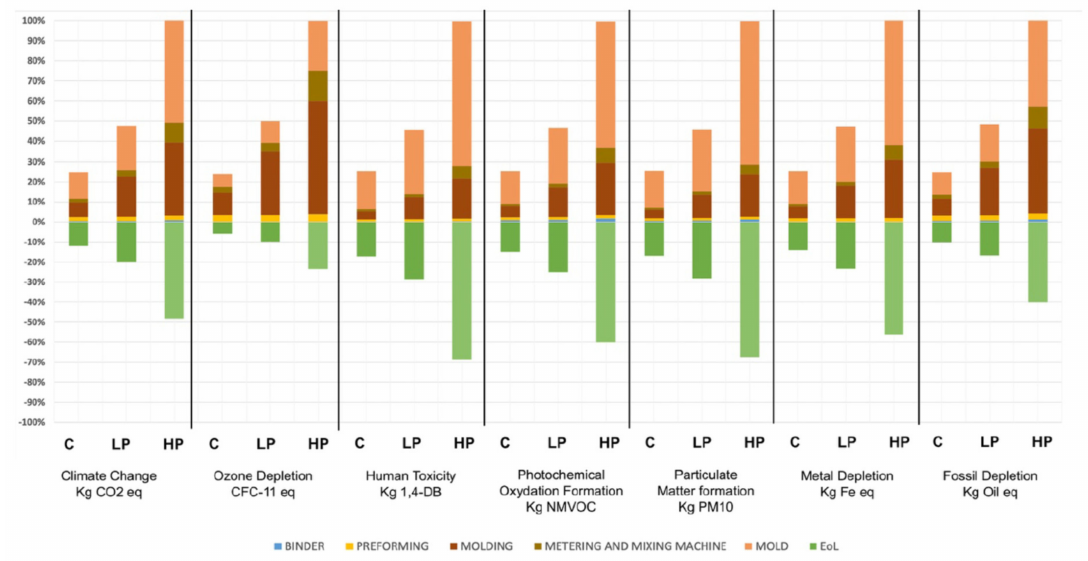
Figure 15. Comparison of the RTM variants in terms of ReCiPe mid-points. Reprinted from [70], © 2020 with permission from